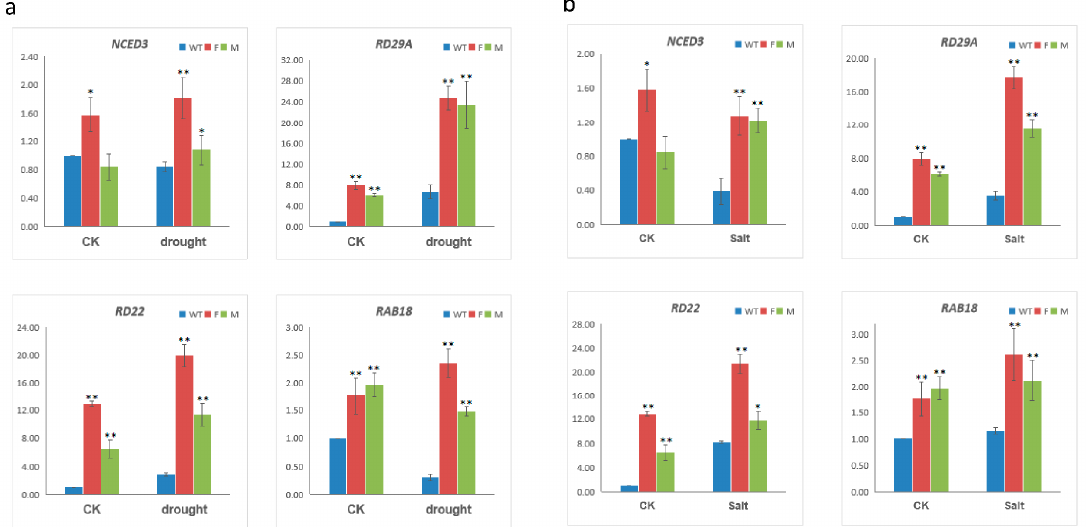
Figure 6. Expression levels of stress-responsive genes in wild-type (WT) and transgenic lines under drought ( a ) and salt ( b ) treatments. Y-axis showed the relative expression levels under normal (CK), drought, and salt treatments. ACT2 gene was used as the internal control. Asterisks indicated significant di ff erence (* p < 0.05, ** p < 0.01, by independent sample T-test) compared to